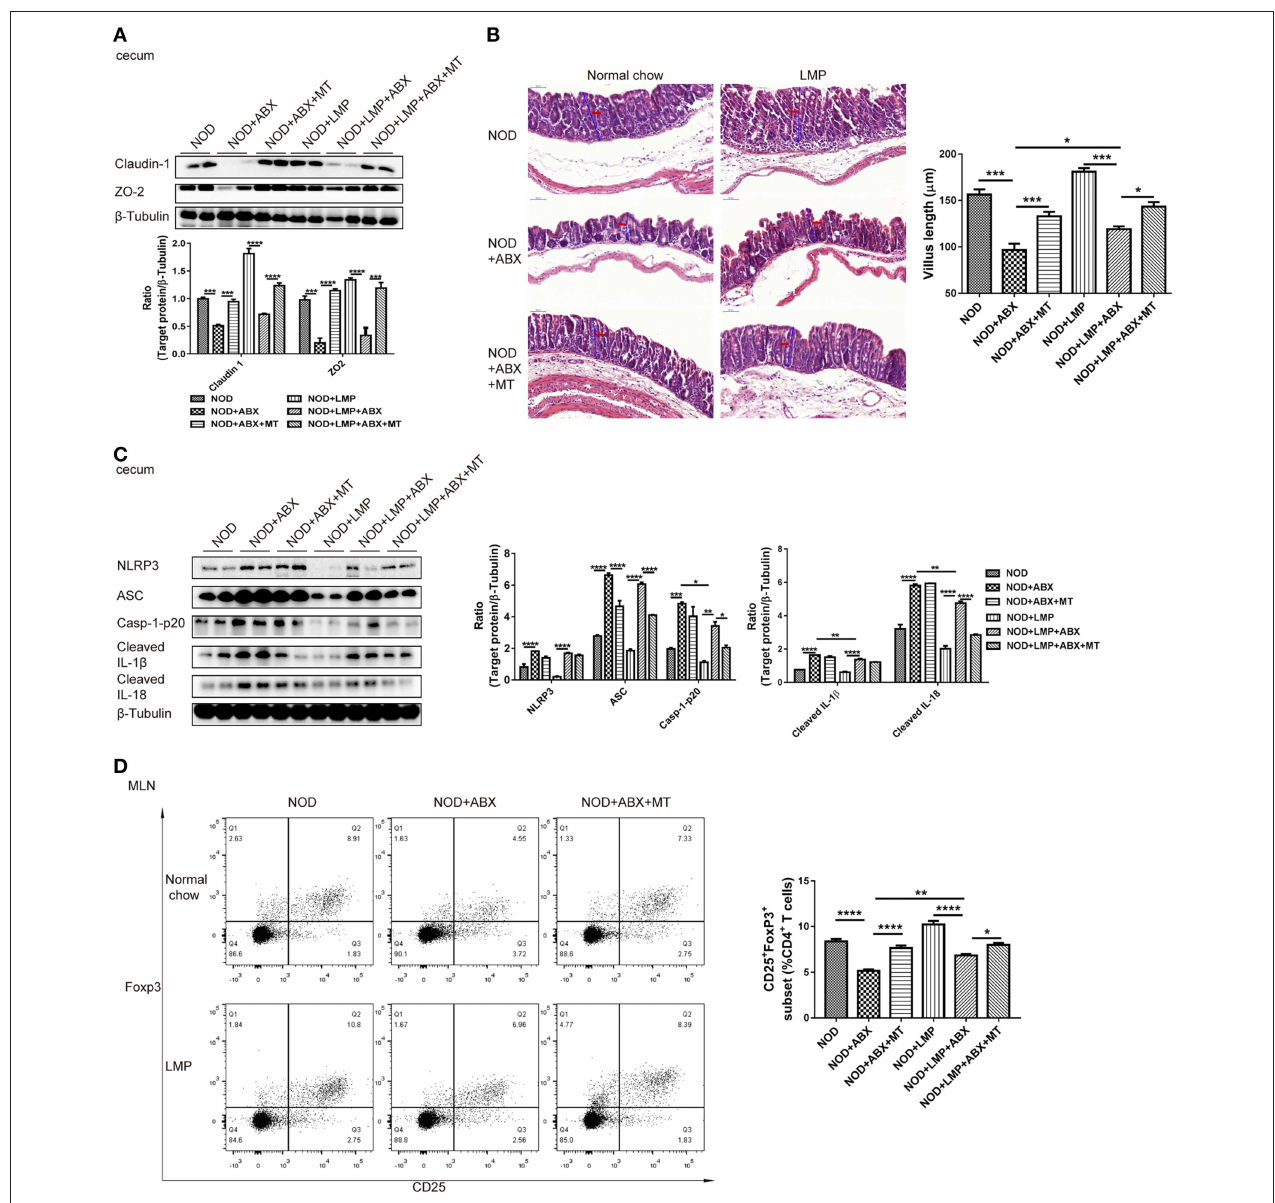
FIGURE 6 | LMP-induced caecal homeostasis is microbiota-dependent. (A) Tight junction proteins claudin-1 and ZO-2 were detected by Western blot analysis. (B) H&E staining of caecum from NOD mice after different treatments at the age of 11 weeks was shown. Scale bar, 50 µ m. (C) Inflammasome pathway proteins, NLRP3, casp-1-p20, cleaved IL-1 β , and cleaved IL-18 in caecum were detected by Western blot analysis. (D) The frequency of CD25 + Foxp3 + cells in total of CD4 + T cells in MLN was analyzed by flow cytometry ( n = 6). Bars represent means ± SEM; * p < 0.05; ** p < 0.01; *** p < 0.001, and **** p <